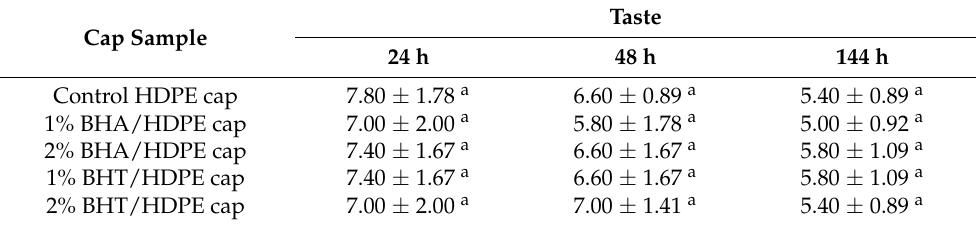
Table 5. Sensory index scores for antioxidant active plastic bottle caps (mean ± SD, n = 6).